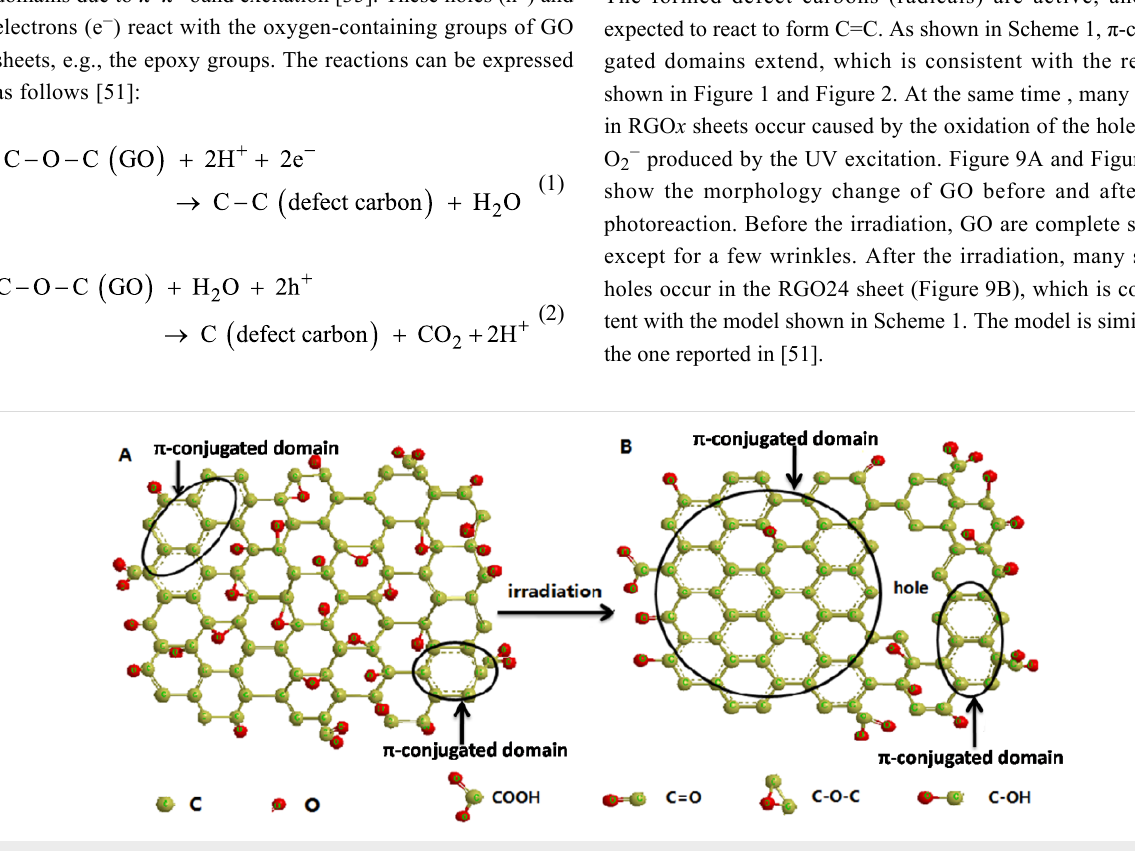
Scheme 1: Schematic diagram of the reduction of GO by irradiation.